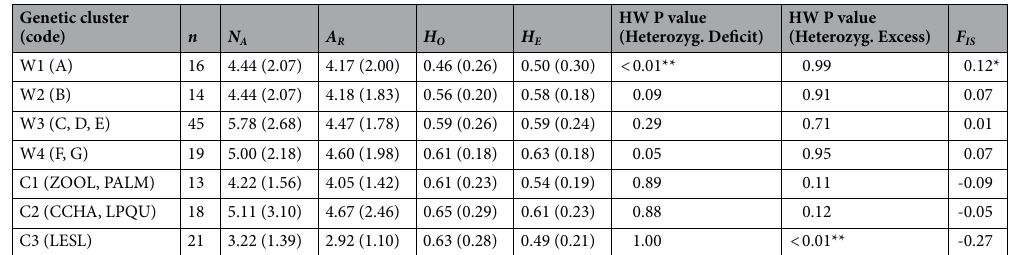
Table 2. Genetic diversity for each cluster of wild and captive red-fronted macaw. Codes represent the sampling sites as shown in Table 3. n number of samples, N A number of alleles, A R allelic richness, H O observed heterozygosity, H E expected heterozygosity, F IS inbreeding coefficients. * p < 0.05; ** p < 0.01.